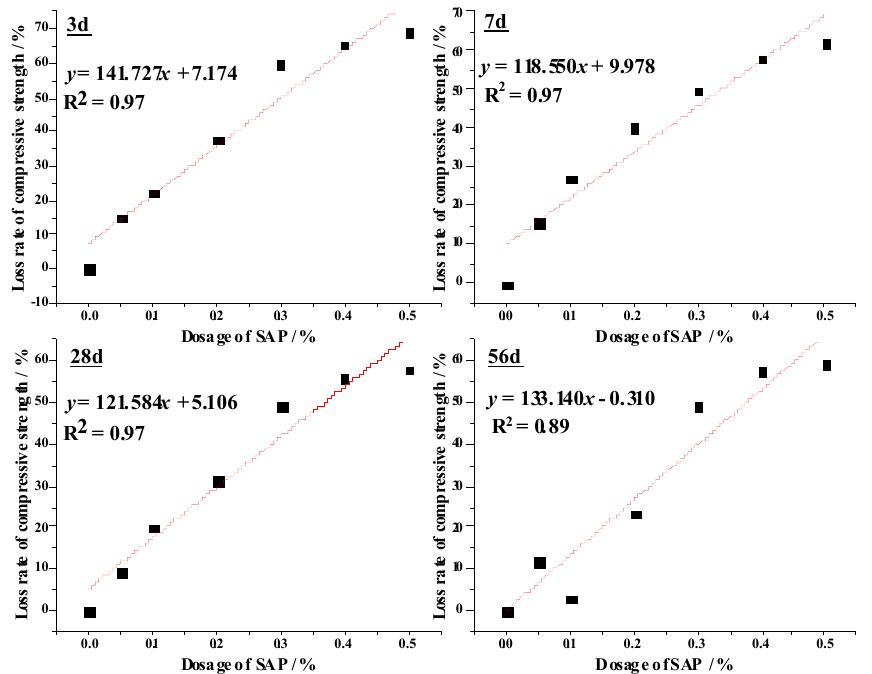
Figure 9. The linear fitting for the loss rate of compressive strength and SAP dosages .